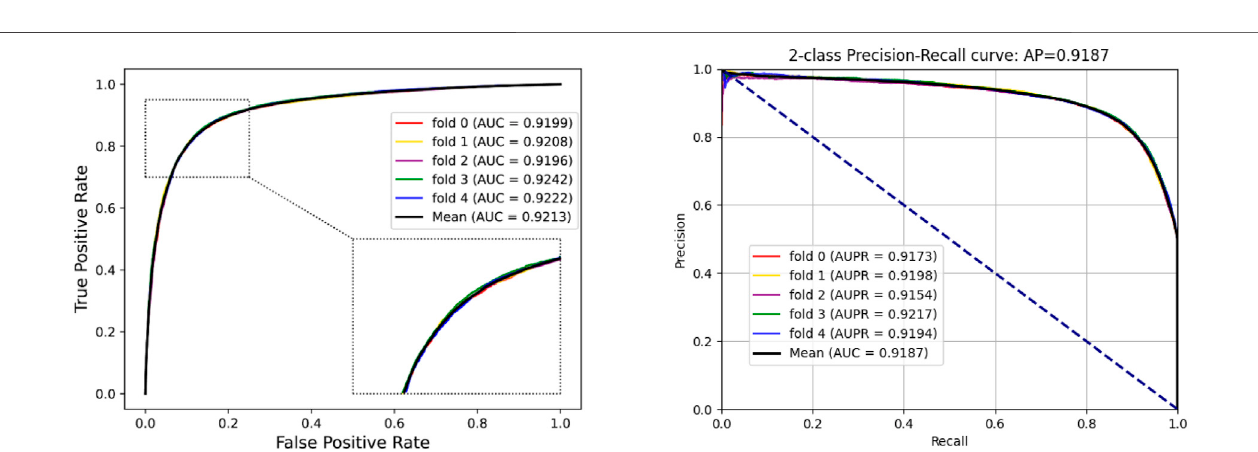
FIGURE 3 | ROC and PR curves yielded by the DWPPI model on the Oryza sativa dataset with the multiple feature.